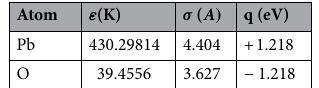
Table 4. Force field parameters for lead